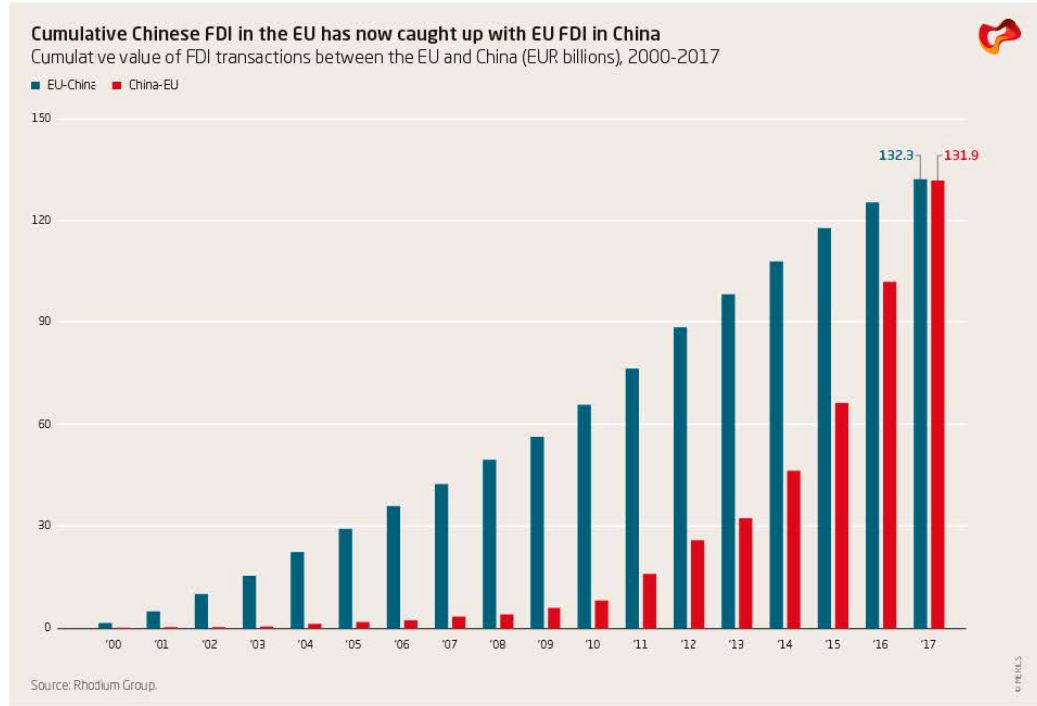
Figure 11 Bilateral Cumulative FDI (2000–17). Source: Thilo Hanemann and Mikko Huotari, ‘EU–China FDI: Working Towards Reciprocity in Investment Relations’ (Mercator Institute for China